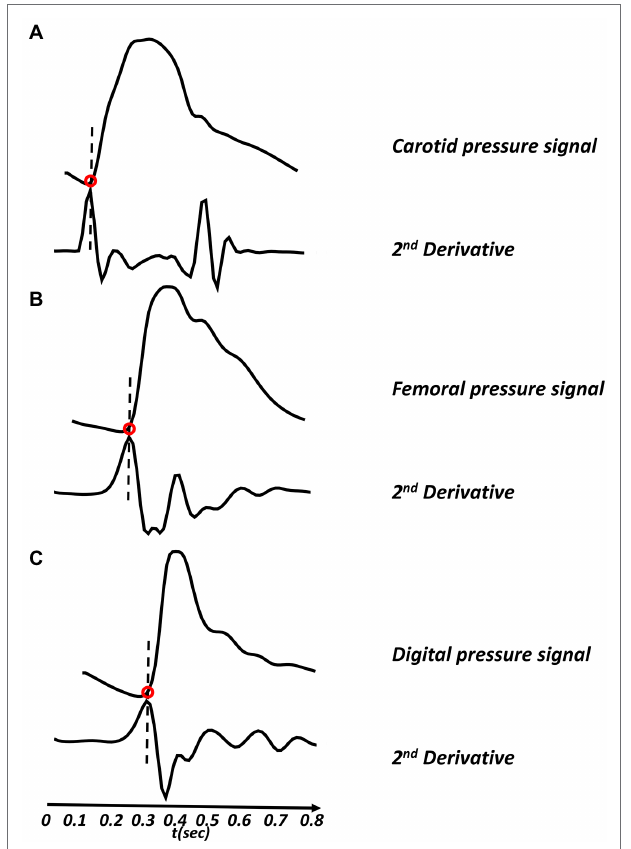
FIGURE 2 | Pulse transit time (PTT) calculation. The figure shows application of Matlab-based second derivative algorithm using the foot-to-foot method. (A) Carotid pressure signal (top) with its second derivative (bottom), (B) femoral pressure signal (top) with its second derivative (bottom), and (C) digital pressure signal (top) with its second derivative (bottom).